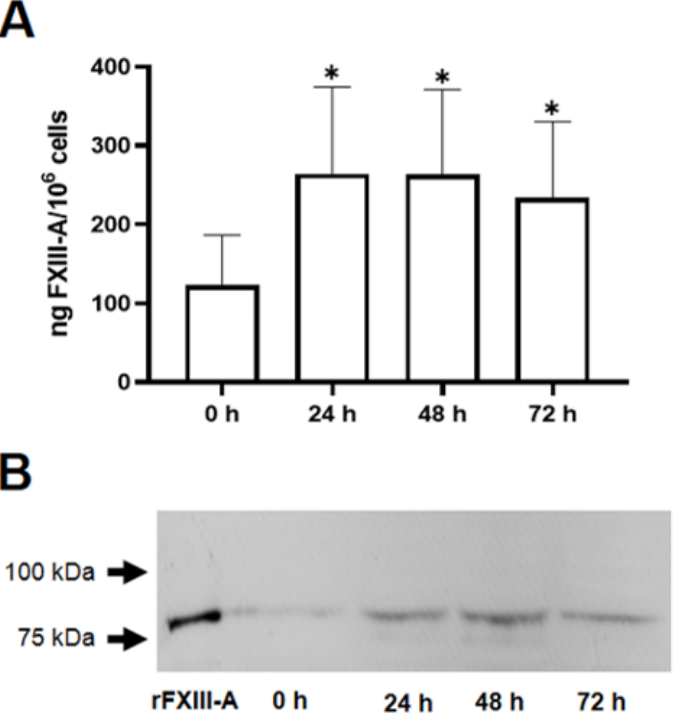
Figure 2. Elevation of FXIII-A in macrophages following their transformation into foam cells by a single dose of 50 µ g/mL oxidized LDL (oxLDL). ( A ) FXIII-A was measured by ELISA in the lysates of non-treated cells and in cells harvested 24, 48, and 72 h after the addition of oxLDL. Statistical significance was calculated by comparing the results of oxLDL-treated cells to those of non-treated cells ( n = 5, * p < 0.05). ( B ) A representative Western blot demonstrates an elevated FXIII-A level in macrophages transformed into foam cells. The arrows indicate the migration of 75 kDa and 100 kDa components of the molecular weight markers in the Precision Plus Protein Standards.